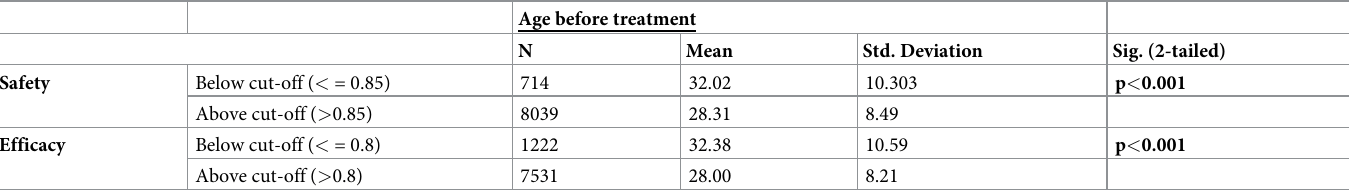
Table 4. Correlation between age and safety and efficacy (T-Test).